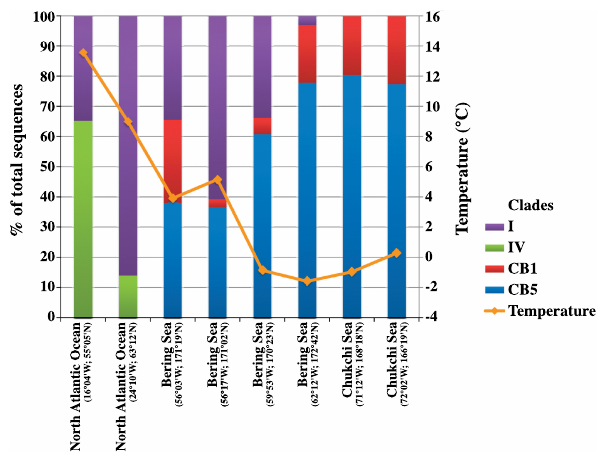
Figure 2. Synechococcus community composition calculated from environmental sequences recovered in high-latitude